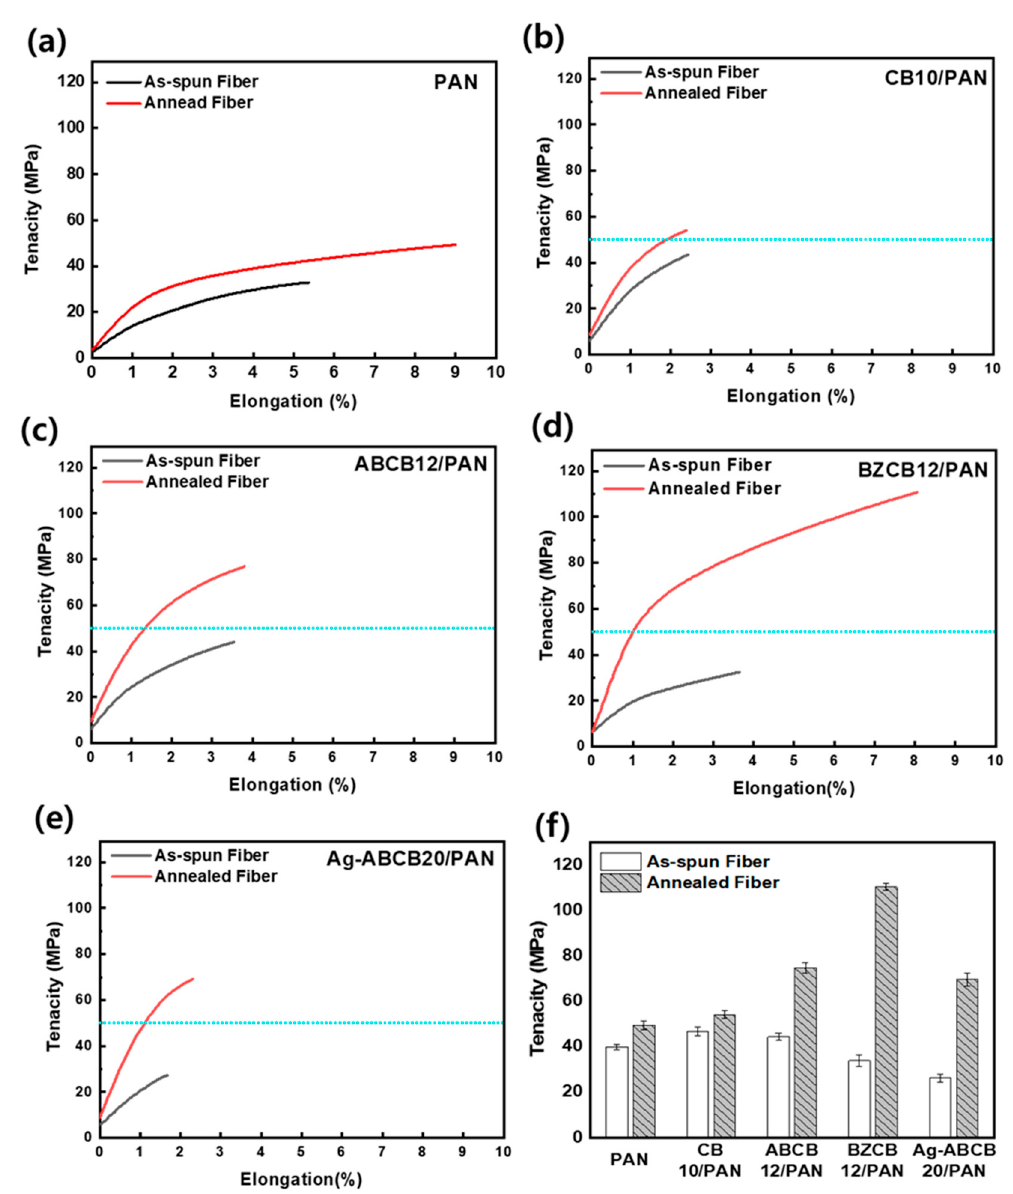
Figure 7. Schematics of ring-opening reaction of the benzoxazine groups in BZCB during annealing.